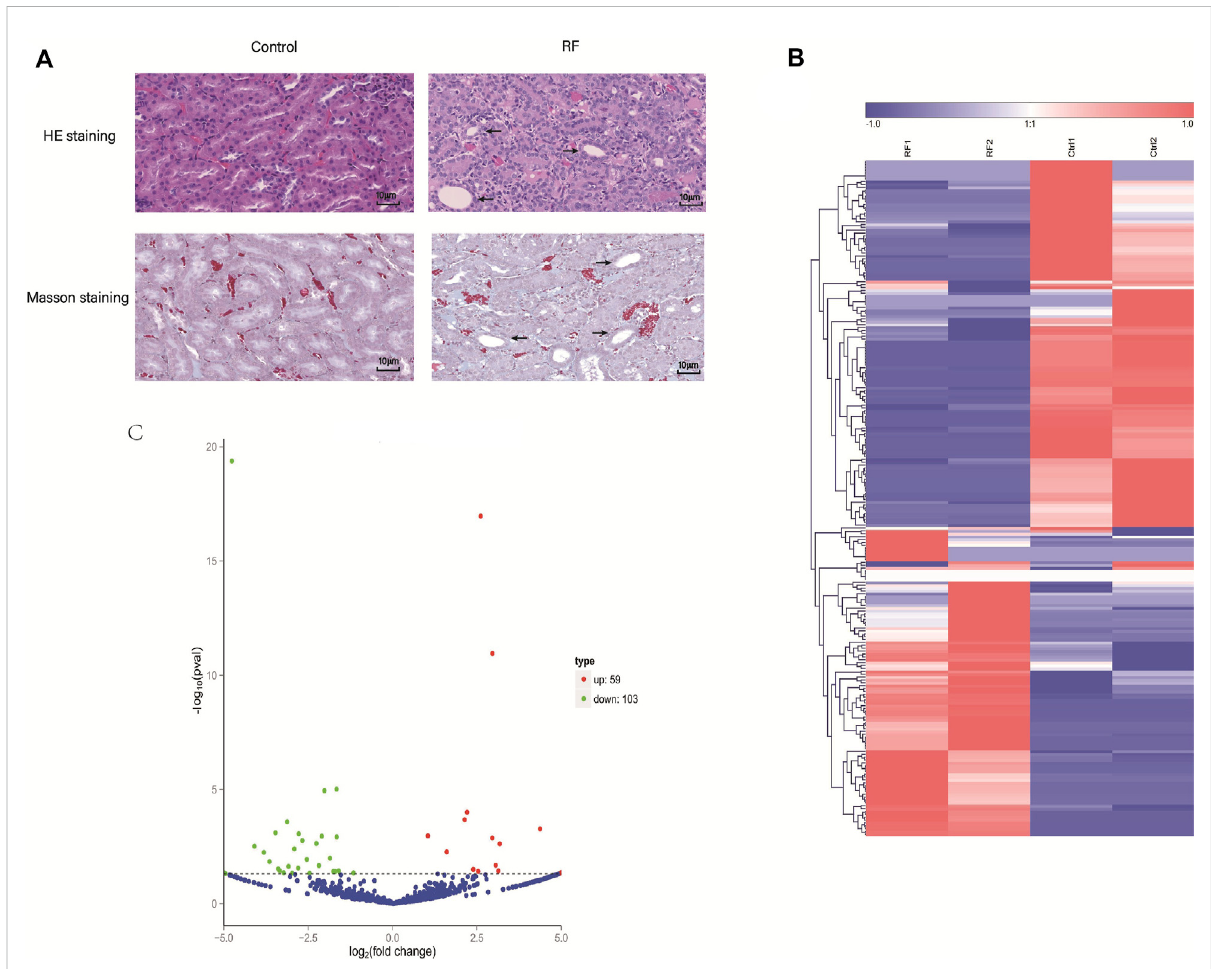
FIGURE 1 Theestablishmentofrenal fi brosis(RF)modelofratsandexplorationofcirRNAsexpression. (A) Hematoxylinandeosin(HE)andMassonstaining was used to detect the degree of injury and fi brosis of renal tissue, respectively. (B) The heat map indicates the differential expression of circRNAs between RF and Ctrl groups (2 samples for each group). The high and low expression of circRNAs are marked in red and green, respectively. (C) Volcano plots of circRNA expression. The two vertical lines represent the differential expression of 2-fold up and down, and the horizontal line represents p = 0.05. Thus, the green dots demonstrate the low expression with statistical difference, and the red dots demonstrate high expression with statistical